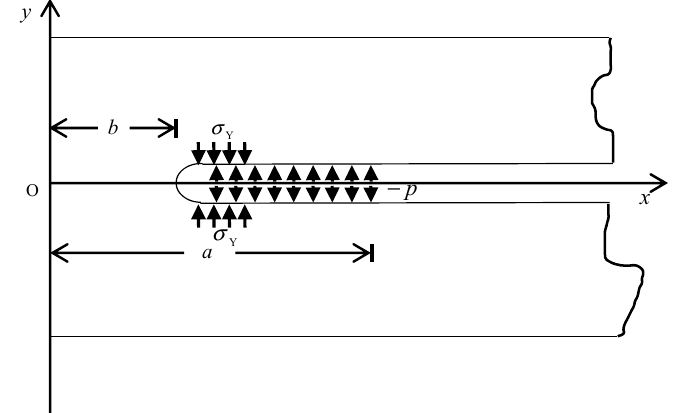
Figure 2. A schematic figure for a semi-infinite crack in a decagonal quasicrystal.